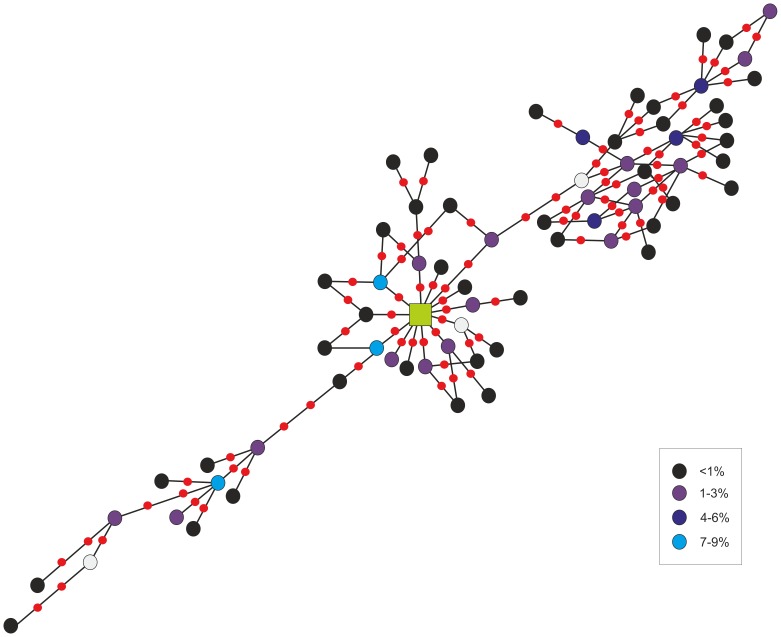
Median-joining network of mtDNA haplotypes corresponding to the period 2004 and 2007–2011.Haplotypes are represented as circles which area is not proportional to its relative frequency for simplicity. Instead, the frequency of haplotypes is depicted through the color code detailed in the legend. The green square represents the ancestral and more abundant haplotype (present in 27% of the individuals). The minimum number of steps connecting parsimoniously two haplotypes is indicated as a red dot, and the open circles represent extinct or missing haplotype that might have not been sampled (mv).